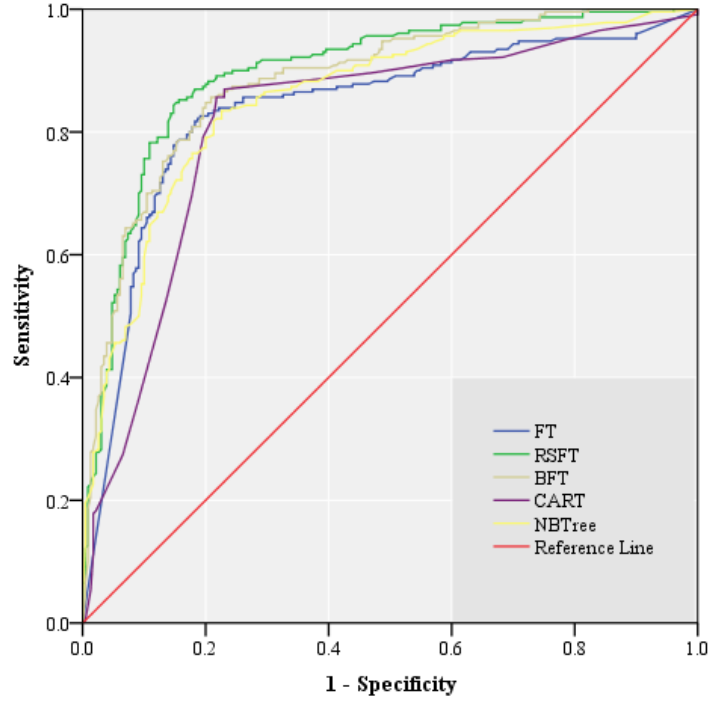
Figure 5. ROC curves of the models using the training dataset. Table 1. Model performance.